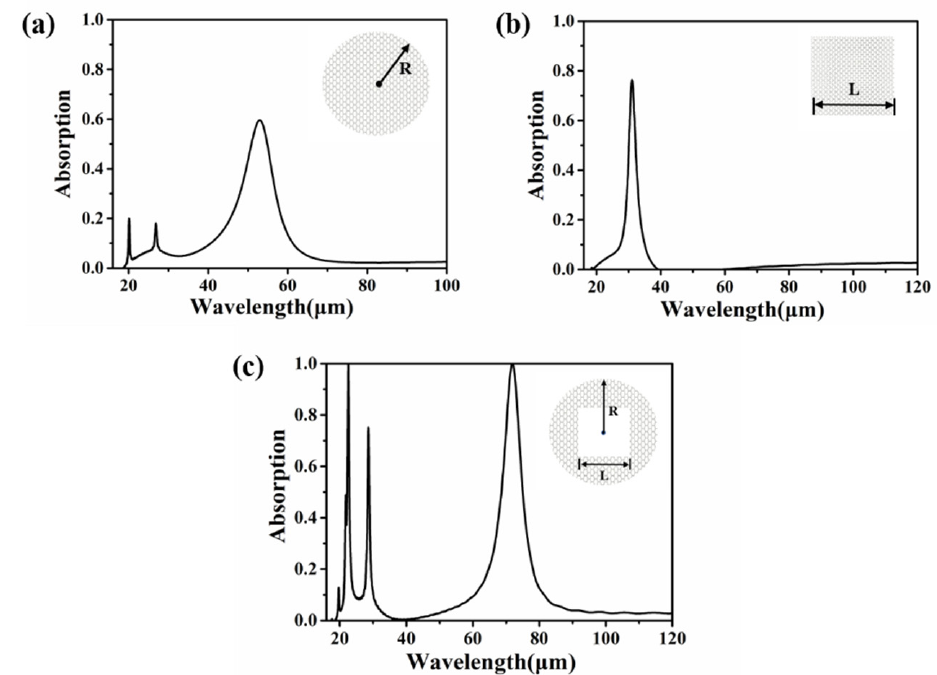
Figure 2. ( a ) A schematic diagram of light absorption of a single-disc-structure graphene absorber and a planform of the absorber, with radius R and period P . ( b ) A schematic diagram of light absorption of a single-square-structure graphene absorber and a planform of the absorber, with side length L and period P . ( c ) The light absorption diagram and planform of the “ancient coin” graphene absorber.